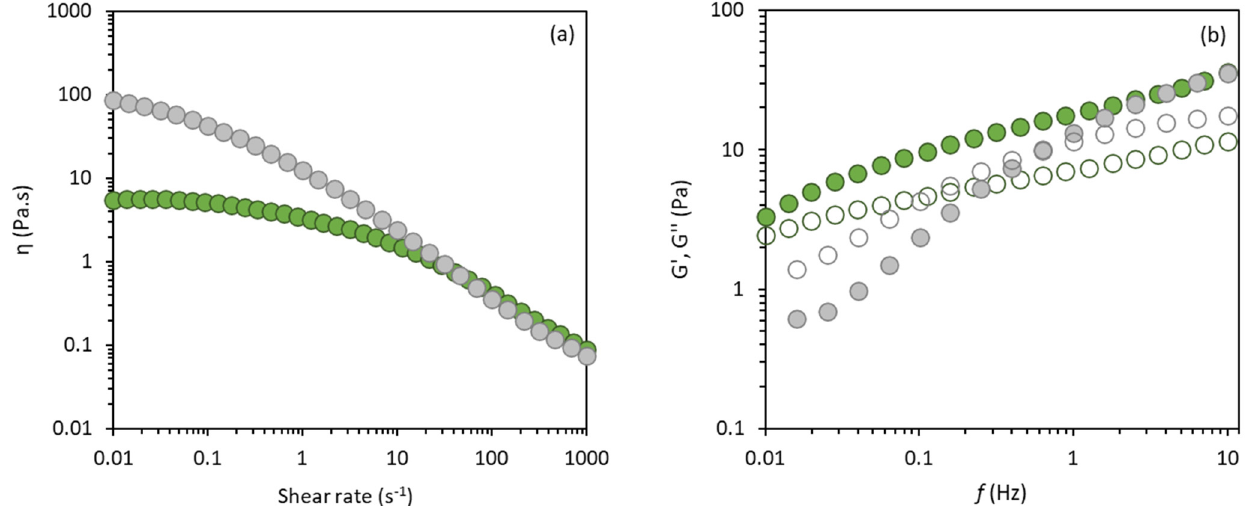
Figure 7 . Rheological profile analysis of olive oil/d − FucoPol emulsion (green) and olive oil/FucoPol emulsion (grey) (o:w weight ratio of 2:3): ( a ) flow curves; ( b ) mechanical spectra: elastic G’ (closed) and viscous G” (open) moduli.